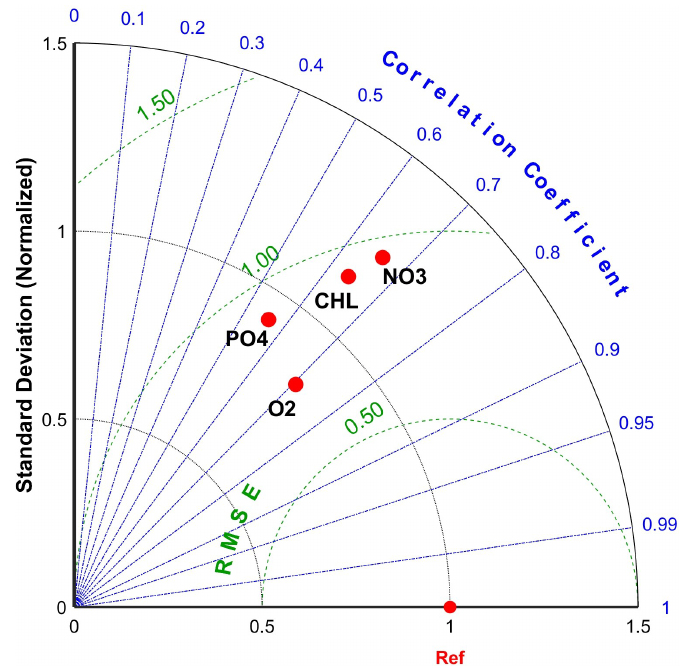
Figure 3. Taylor diagram where the reference point indicate VIEP measurements.